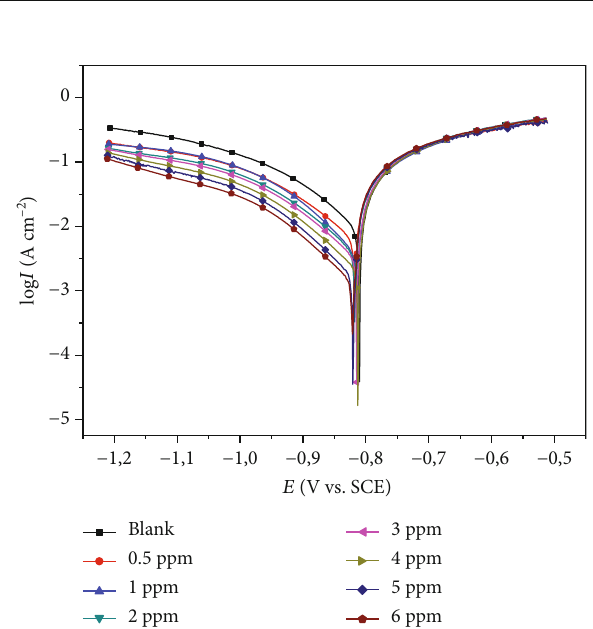
Figure 1: Polarization curves of AA3003 alloy in 1 M HCl solution without and with addition of OMW at di ff erent concentrations (at 298